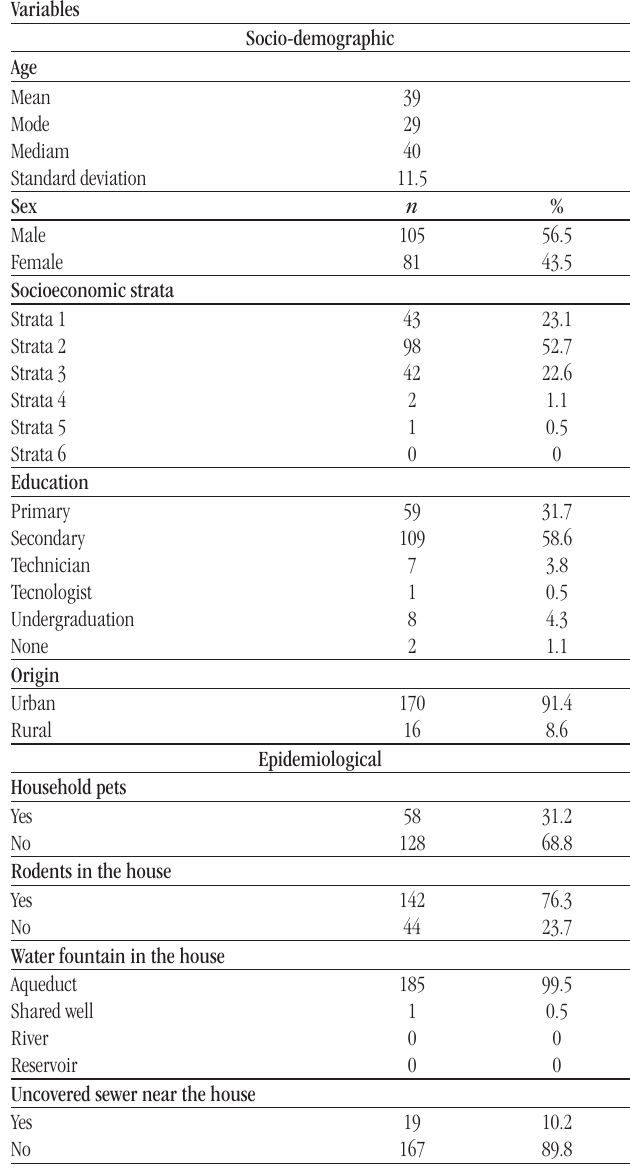
taBLE 1 − Description of sociodemographic and epidemiological variables of the study population